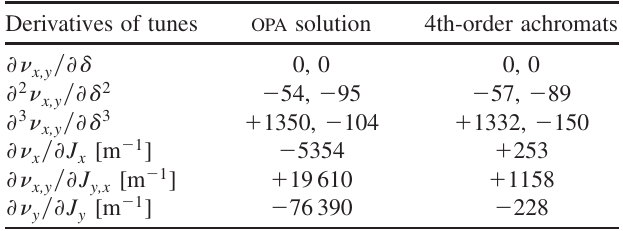
TABLE IV. The nonlinear chromaticities and tune shifts due to betatron amplitudes in the PEP-X ultimate storage